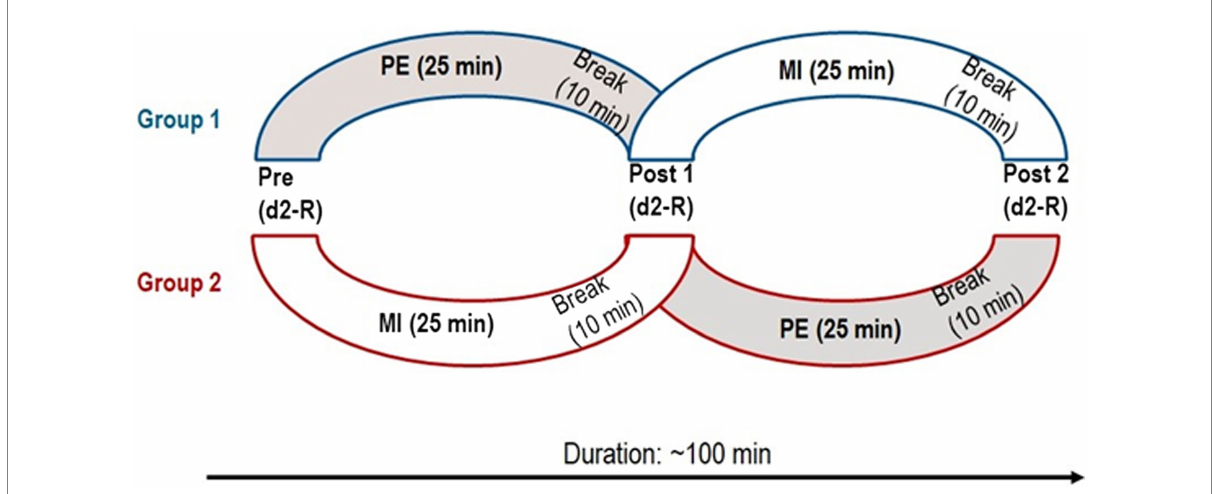
FIGURE 1 Timeline of the experiment. Group 1 first completed the physical exercise (PE) and then the mental imagery exercise (MI). Group 2 first completed MI and then PE. Both groups completed a test for sustained attention (d2-R) three